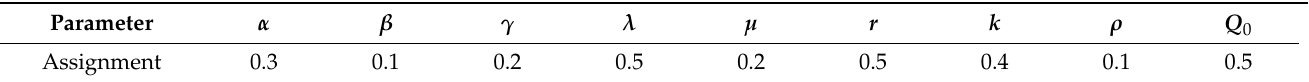
Table 1. Parameter